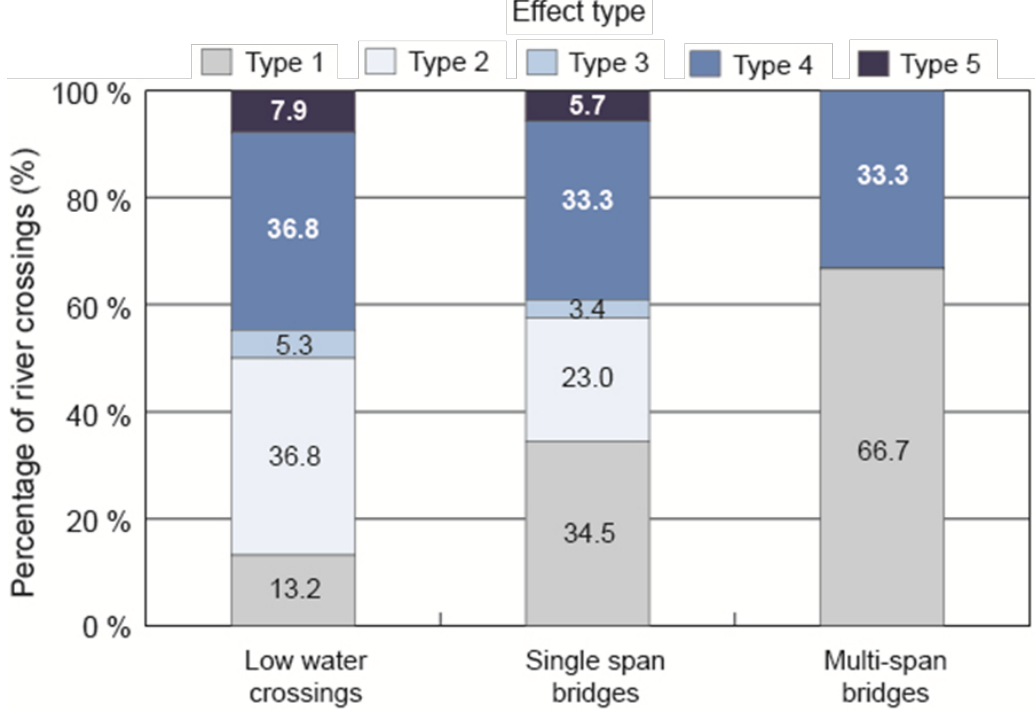
Figure 8. Percentages of effect type on river